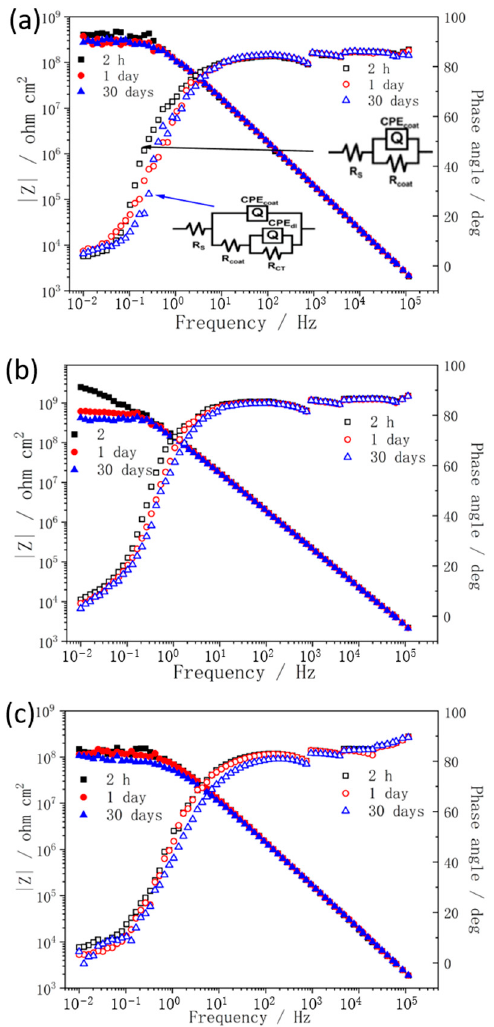
Figure 7. Impedance spectra for carbon steel coated with Alkyd − T2 ( a ), Alkyd − T5 ( b ), and Alkyd − T8 ( c ), in 3.5 wt% NaCl solution.